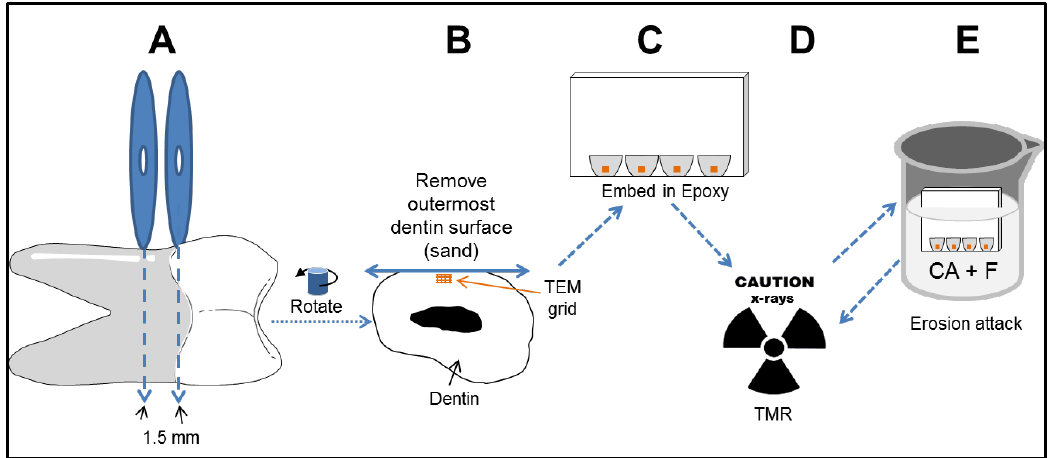
Figure 1. Schematic for sample preparation and erosion challenges.